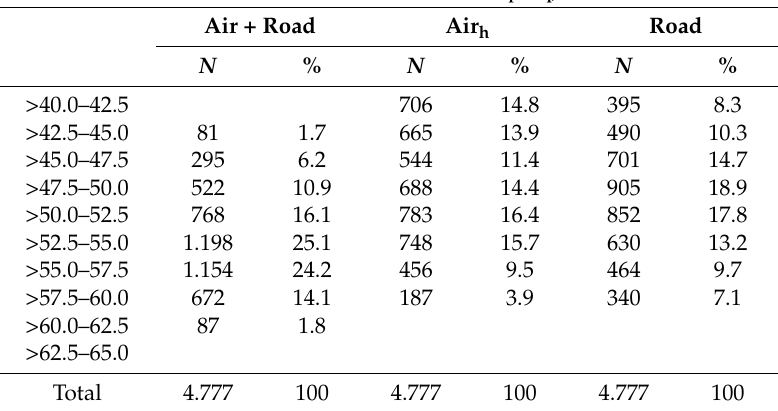
Table 3. Number of respondents in each 2.5 dB sound class of the average sound pressure level L pAeq,24h of aircraft and railway, aircraft and railway noise.